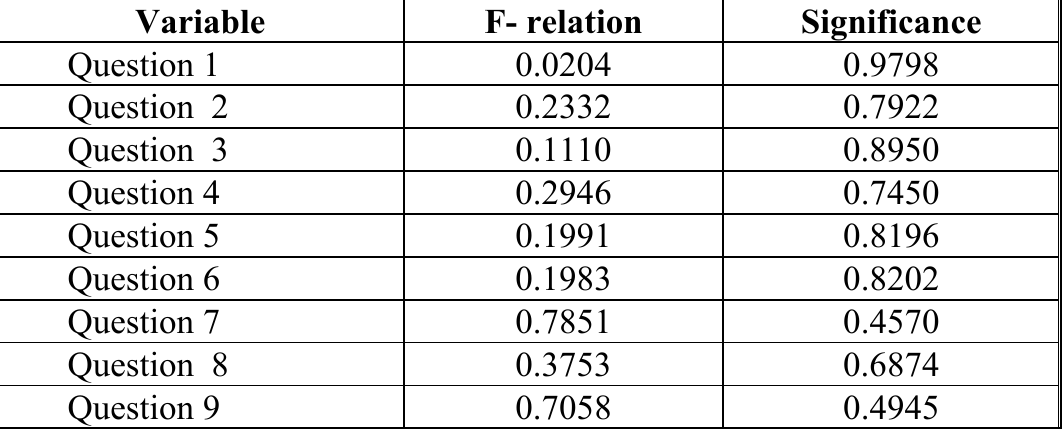
One-way Analysis of Variance results for the independent variable: number of times evaluated Variable F-